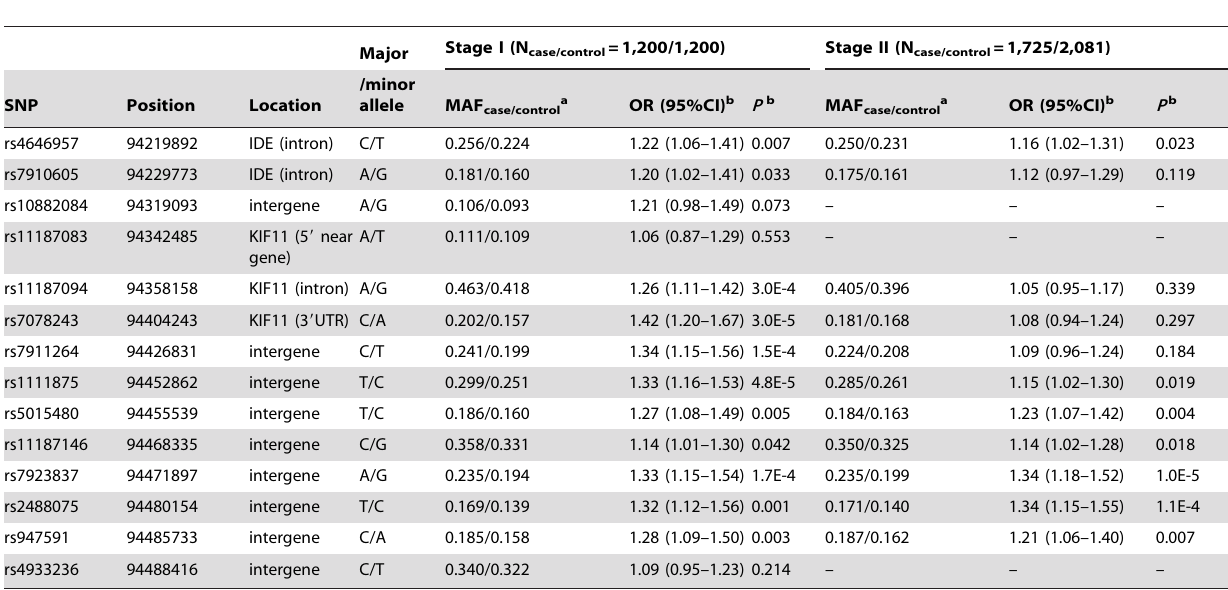
Table 2. Summary results of associations between 14 tagging SNPs at 10q23.33 and risk of type 2 diabetes in two stages.